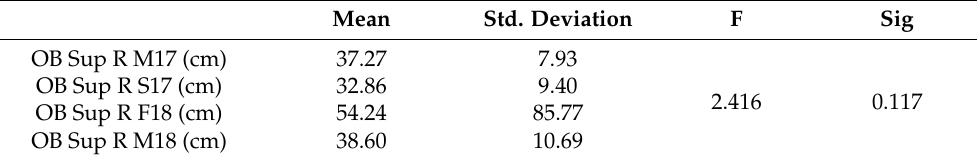
Table 5. OB values in the superolateral direction of the right arm. Mean Std. Deviation F Sig